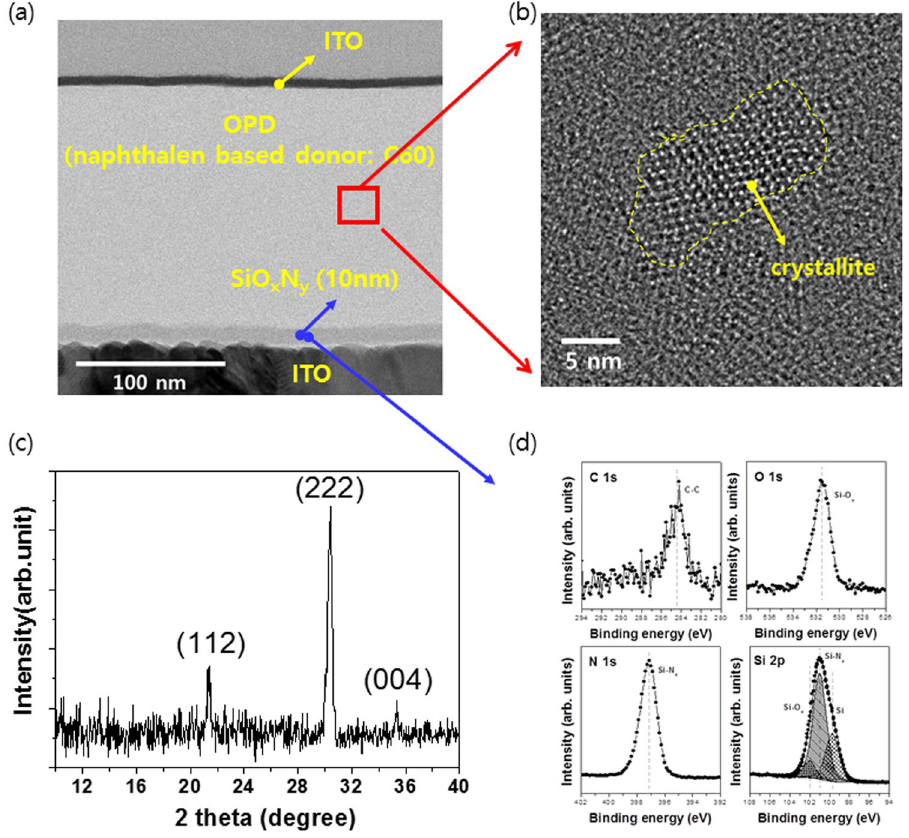
Figure 2. ( a ) Cross-sectional TEM image and ( b ) enlarge a rectangle of TEM image ( c ) the result of XRD ( d ) the XPS spectrum in Si-rich SiO x N y buffer layer of the S2 sample.